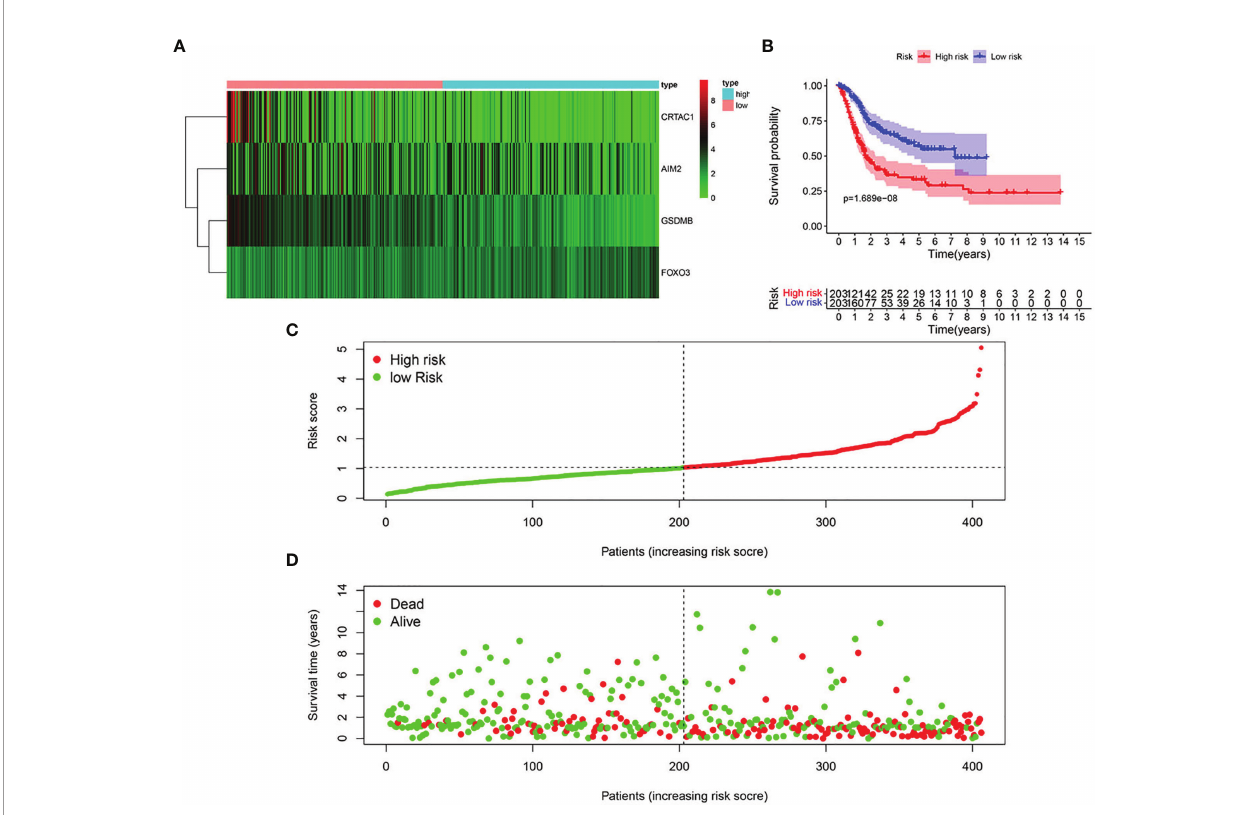
FIGURE 5 | Structure of pyroptosis prognosis model in BLCA. (A) Heatmap displaying the expression patterns of those 4 key genes (B) K-M survival curve analysis. (C) Risk score distribution for BLCA cases. (D) OS for BLCA patients.